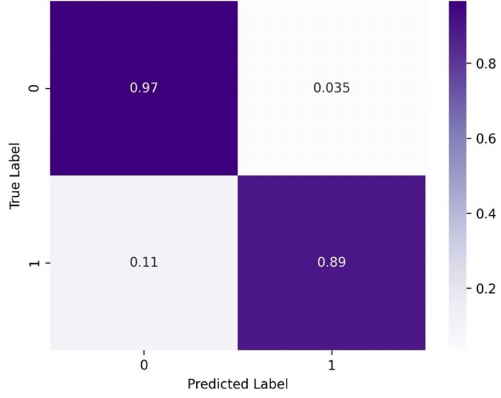
Figure 9. Confusion matrix of